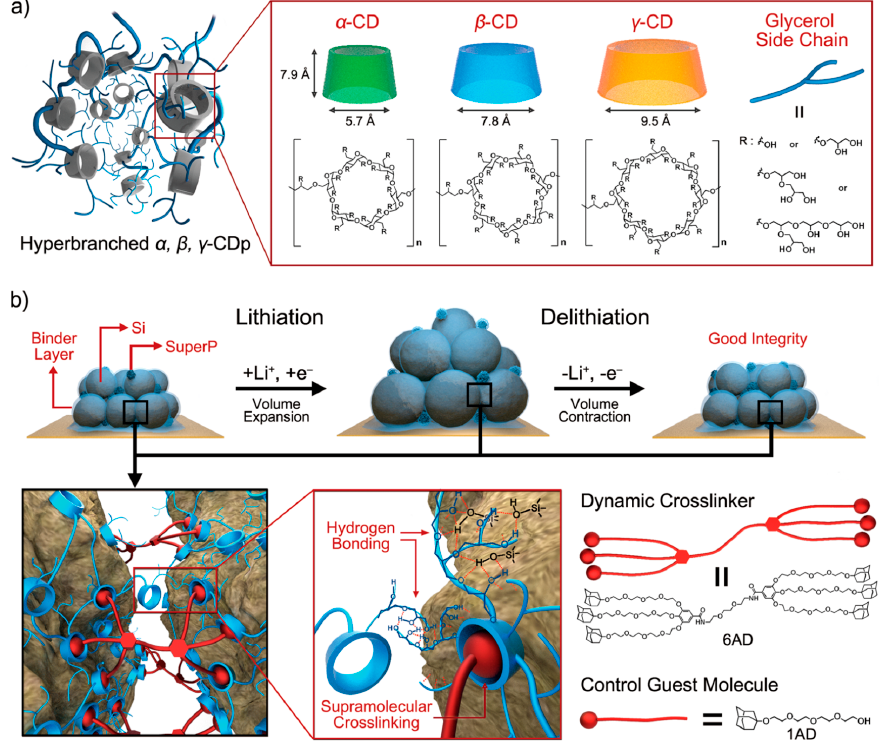
Figure 15. ( a ) Schematic and structures of hyperbranched R-, β -, and γ -cyclodextrin polymer (CDp); ( b ) Dynamic cross-linking mechanism of β -CDp and 6 adamantane (AD) in an electrode matrix along with schematic and structures of guest molecules incorporating AD moiety. Adapted with permission from [160], © American Chemical Society, 2015.